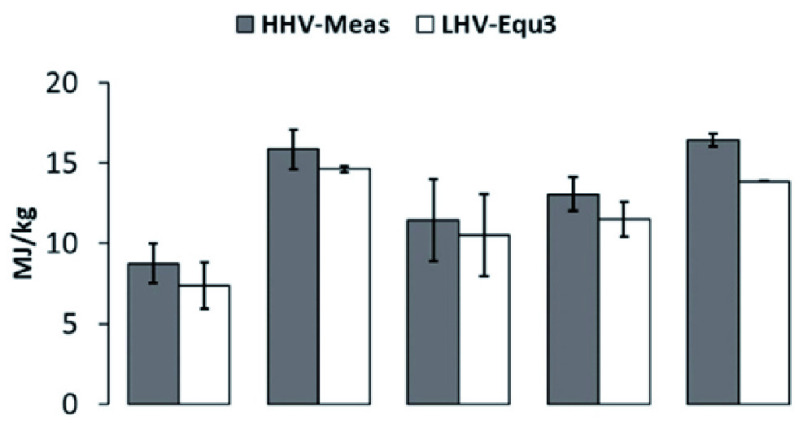
Calorific content of the fecal sludge in Tiruppur.Measured HHV and LHV calculated according to
Equation 3 by source category: pilot study, public community toilet, industrial, multifamily, and single family establishment (errorbar: st. dev).